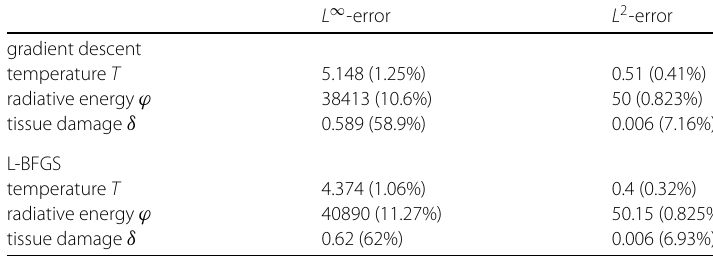
Table 5 Comparison between the simulated and measured temperature for multiple noisy